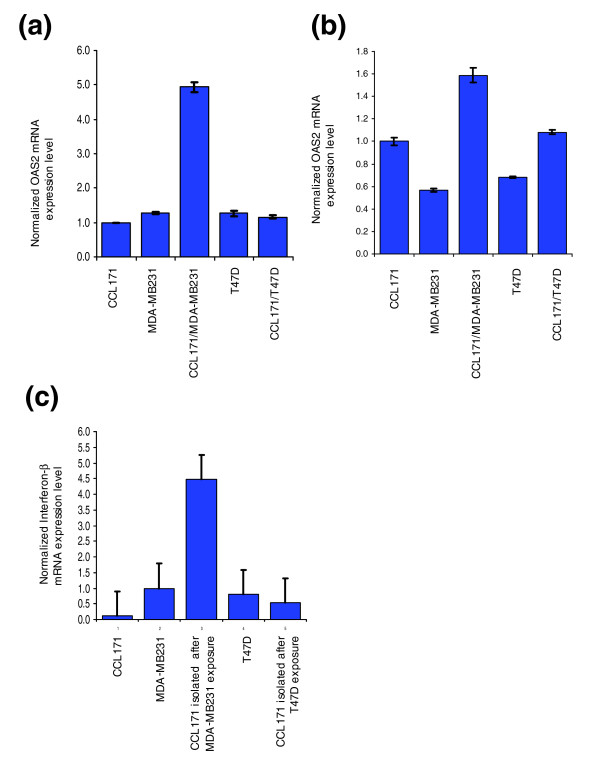
Induction of interferon response in two types of breast cancer cell lines. (a) MDA-MB231 cells were incubated in conditioned media from CCL-171 monoculture, MDA-MB231 monoculture, T47D monoculture, CCL-171/MDA-MB231 co-culture and CCL-171/T47D co-culture. OAS2 gene expression was determined by quantitative RT-PCR. The gene expression level of GAPDH was used for normalization between the samples. A strong induction of OAS2 by the supernatant from the CCL-171/MDA-MB231 co-culture can be seen in MDA-MB231. (b) Incubation of T47D cells with conditioned media from CCL-171 monoculture, MDA-MB231 monoculture, T47D monoculture, CCL-171/MDA-MB231 co-culture and CCL-171/T47D co-culture showed that only the CCL-171/MDA-MB231 co-culture supernatant induced OAS2 gene expression, although to a much lesser extent than in MDA-MB231 cells. (c) Gene expression levels of IFNβ were determined by quantitative RT-PCR. CCL-171 cells show much higher IFNβ expression levels when isolated by FACS after co-culture with MDA-MB231 than with T47D cells. Expression levels in tumor cells are shown as controls. The error bars show the standard deviation from the normalized mean.